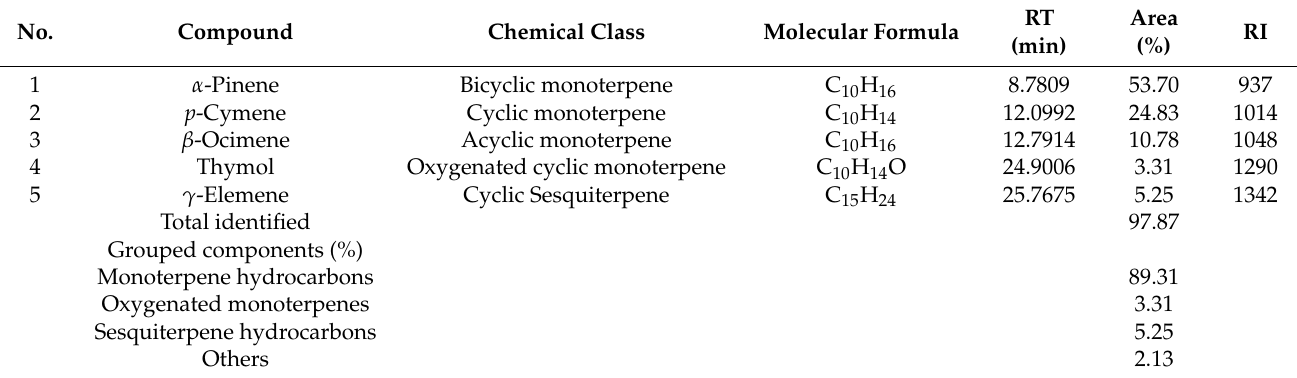
Table 2. Chemical constituents identified from the essential oil of Juniperus procera .